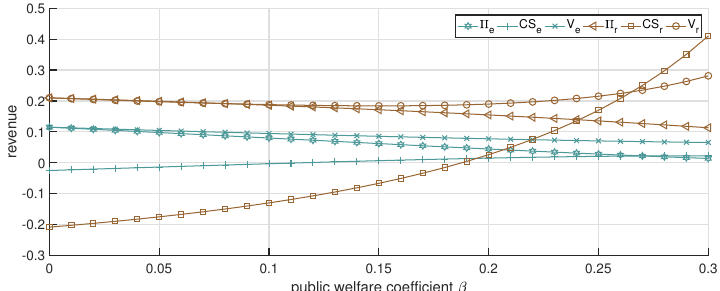
Figure 6. The impact of changes in β on CS and V (dual-channel strategy p 0 =